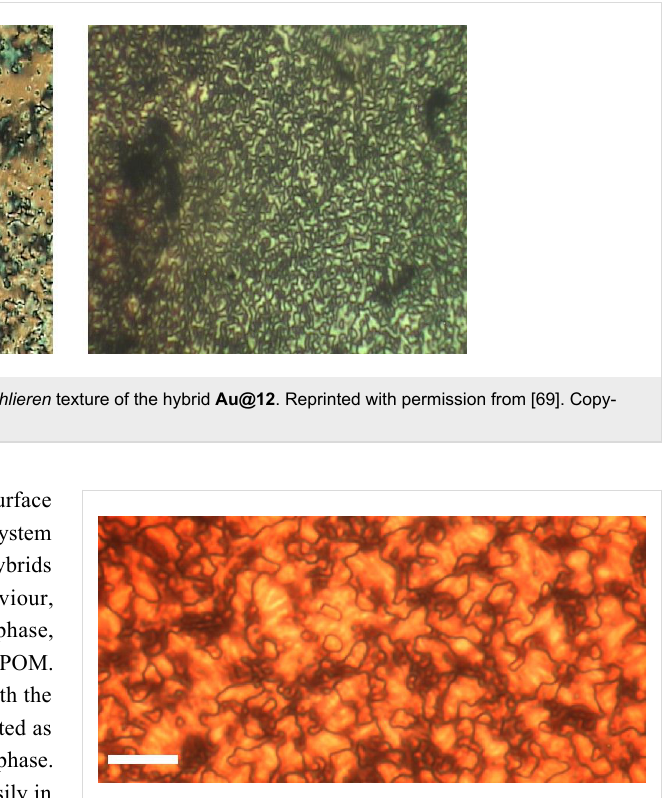
Figure 15: Threaded nematic texture of Au@ C 12 /13 as observed by POM at RT. Scale bar = 10 μ m. Reprinted with permission from [65]. Copyright 2009 Wiley-VCH Publishers.